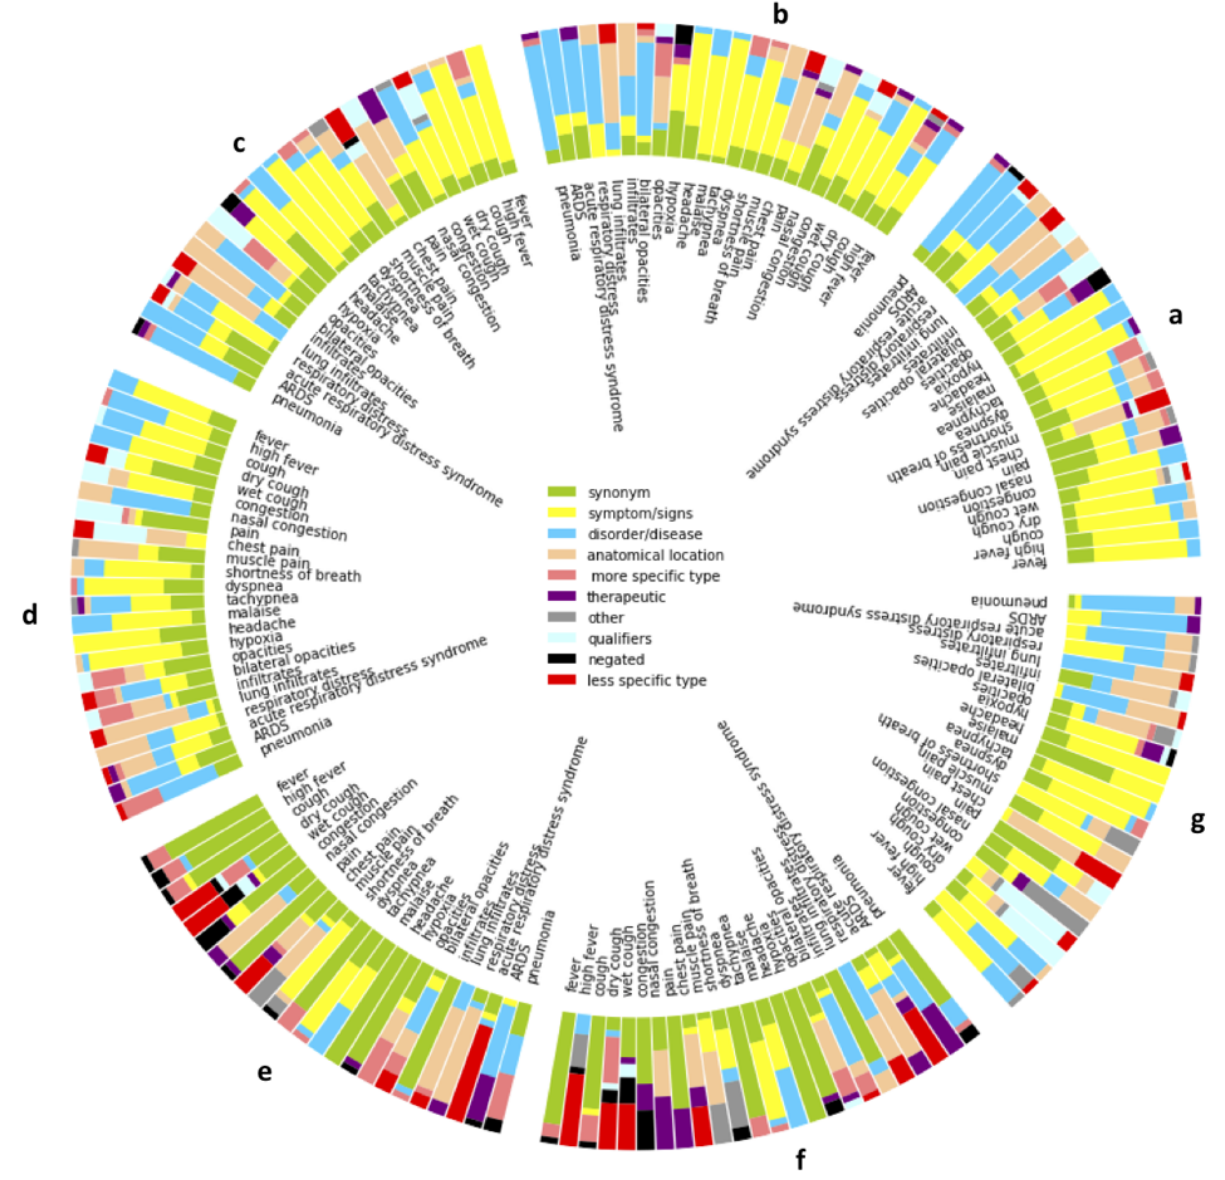
Figure 9. For each symptom, finding, and disorder queried term, the distribution of semantic types for returned term colored by semantic type for each embedding source: (a) BioNLP Lab PubMed + PMC W2V, (b) BioNLP LabWiki + PubMed + PMC W2V, (c) BioASQ, (d) Clinical